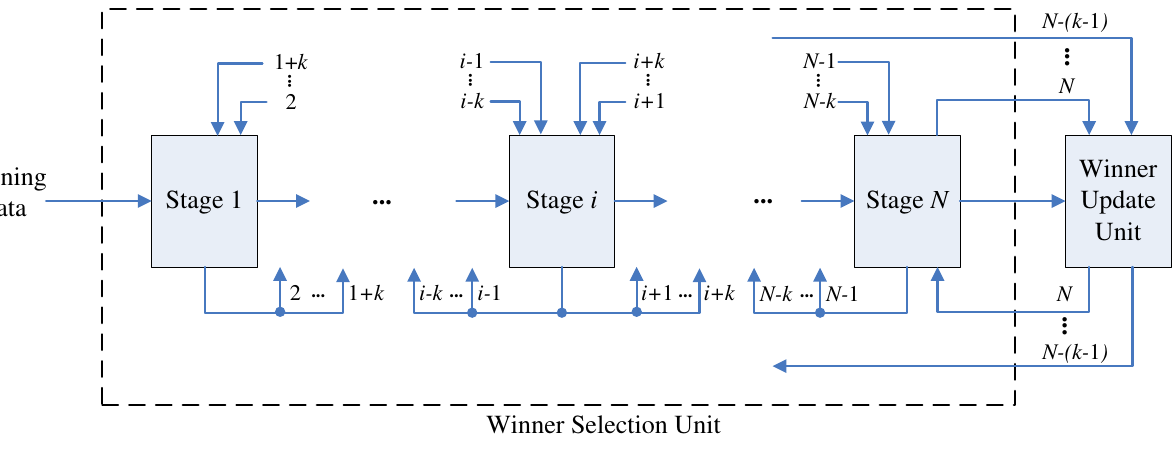
Figure 1. The proposed CL